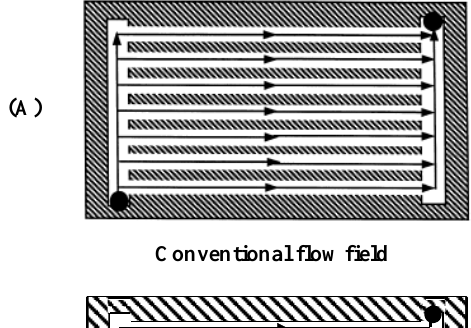
Figure 9. Three typical flow field designs (A) conventional flow field, (B) serpentine flow field and (C) interdigitated flow field are shown